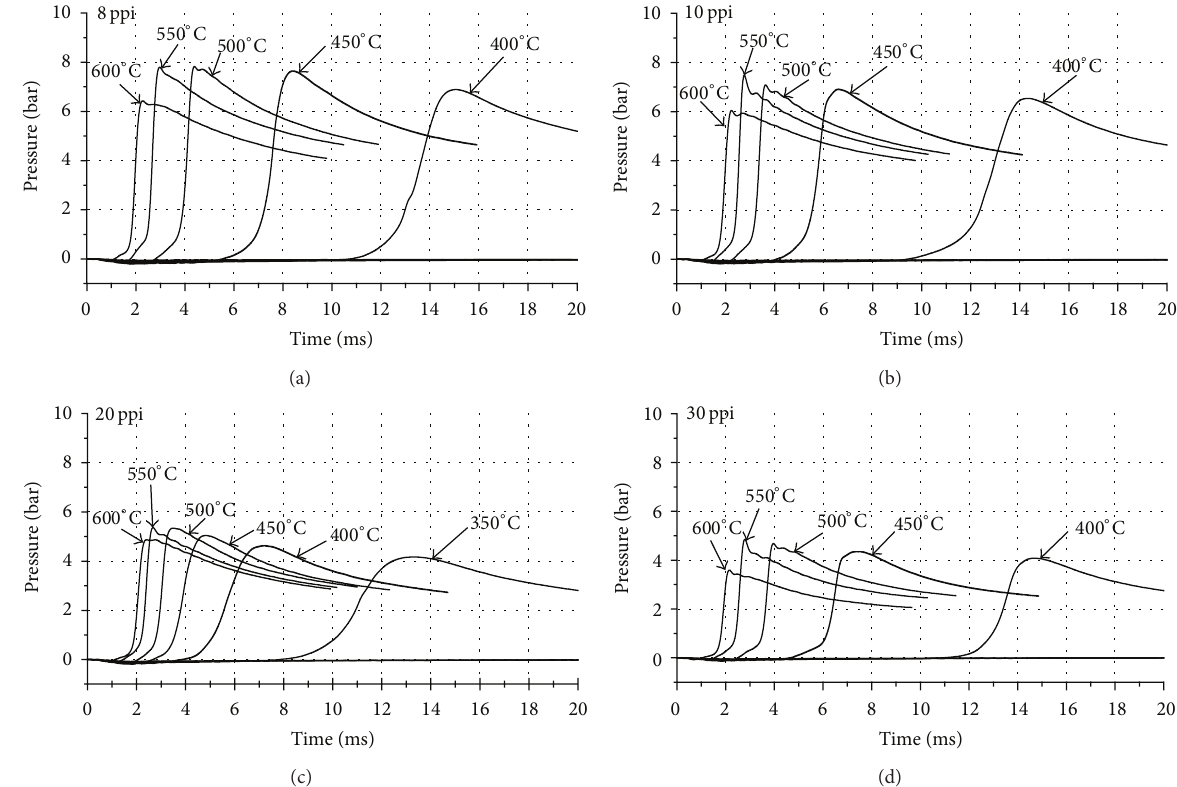
Figure 13: Comparison of pressure histories for heat release in different SiC foam porous reactors after fuel injection starts for a constant mass of injected fuel (26.3mg) and for a constant air excess ratio (initial pressure and initial temperature are not